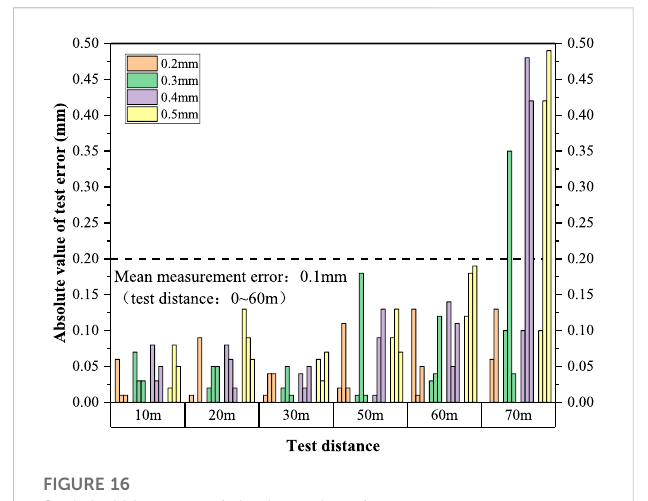
FIGURE 16 Statistical histogram of absolute value of test error.